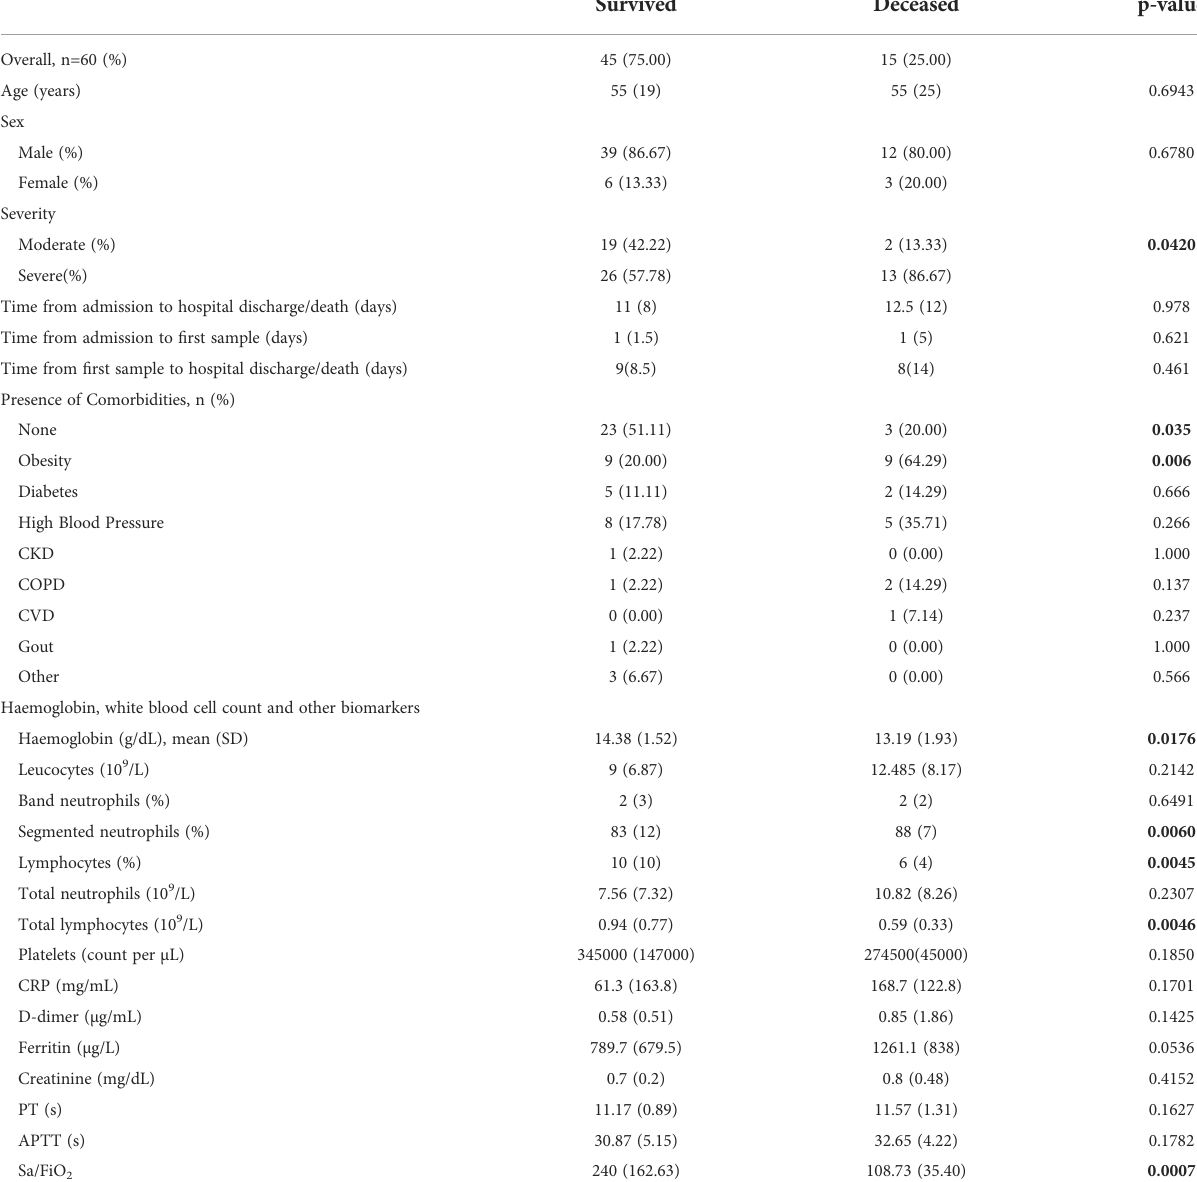
TABLE 1 Characteristics of the study cohort by outcome at